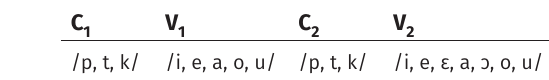
Table 2: Structure of first two syllables of the